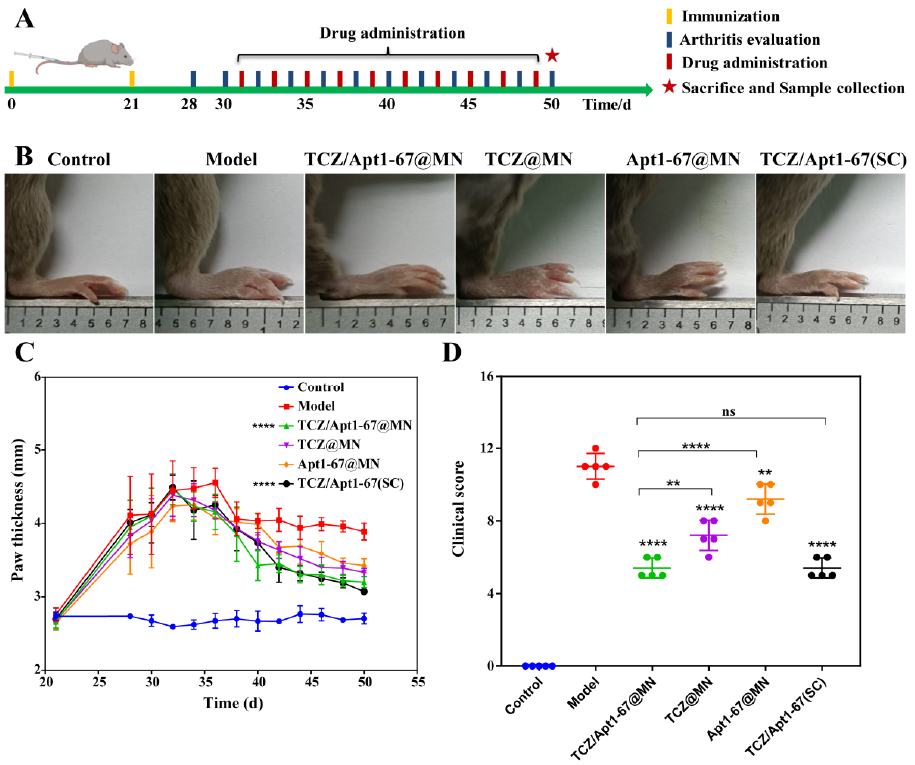
Figure 5. Anti ‐ RA activity of the separable MN in vivo. ( A ) Outline of the in vivo experiments. ( B ) Images of the paws of the mice after various treatments. ( C ) Time ‐ dependent paw thickness with various treatments. ( D ) Clinical score of the mice after various treatments. **: p < 0.01; ****: p < 0.0001; ns: not significant.